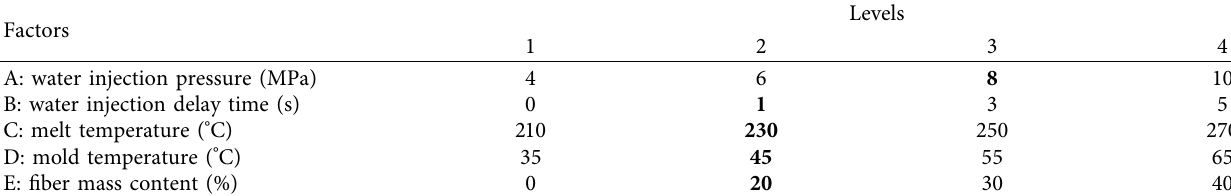
Table 3: Levels of factors used in experiments.